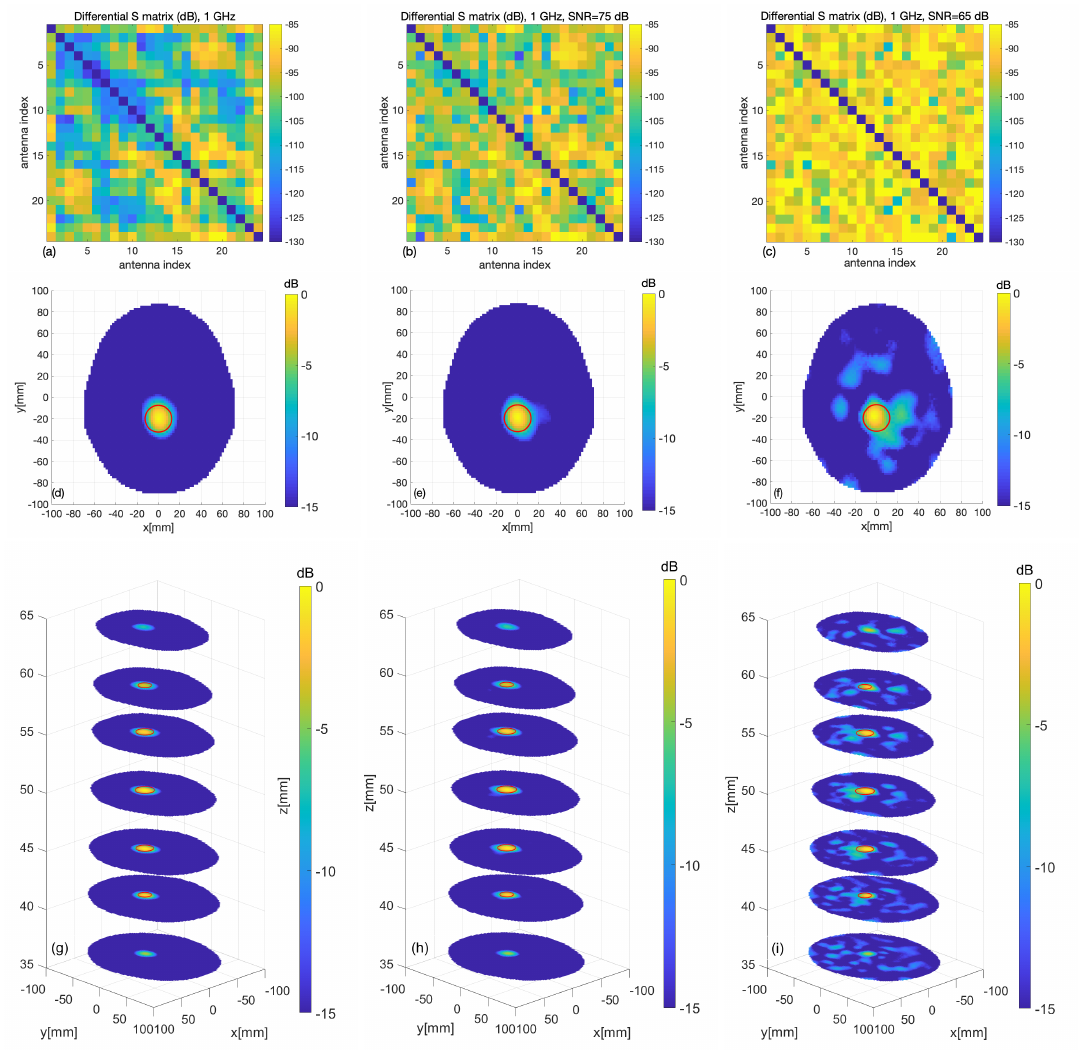
Figure 10. Digital twin: case of a target blood sphere; the exact sphere location and shape are indicated by red circles. ( a – c ) Differential scattering matrices; ( d – f ) cross-sections of the reconstructed images at the sphere center and ( g – i ) at various levels, for different values of the signal-to-noise ratio (left column: no noise, middle column: SNR = 75dB , right column: SNR =